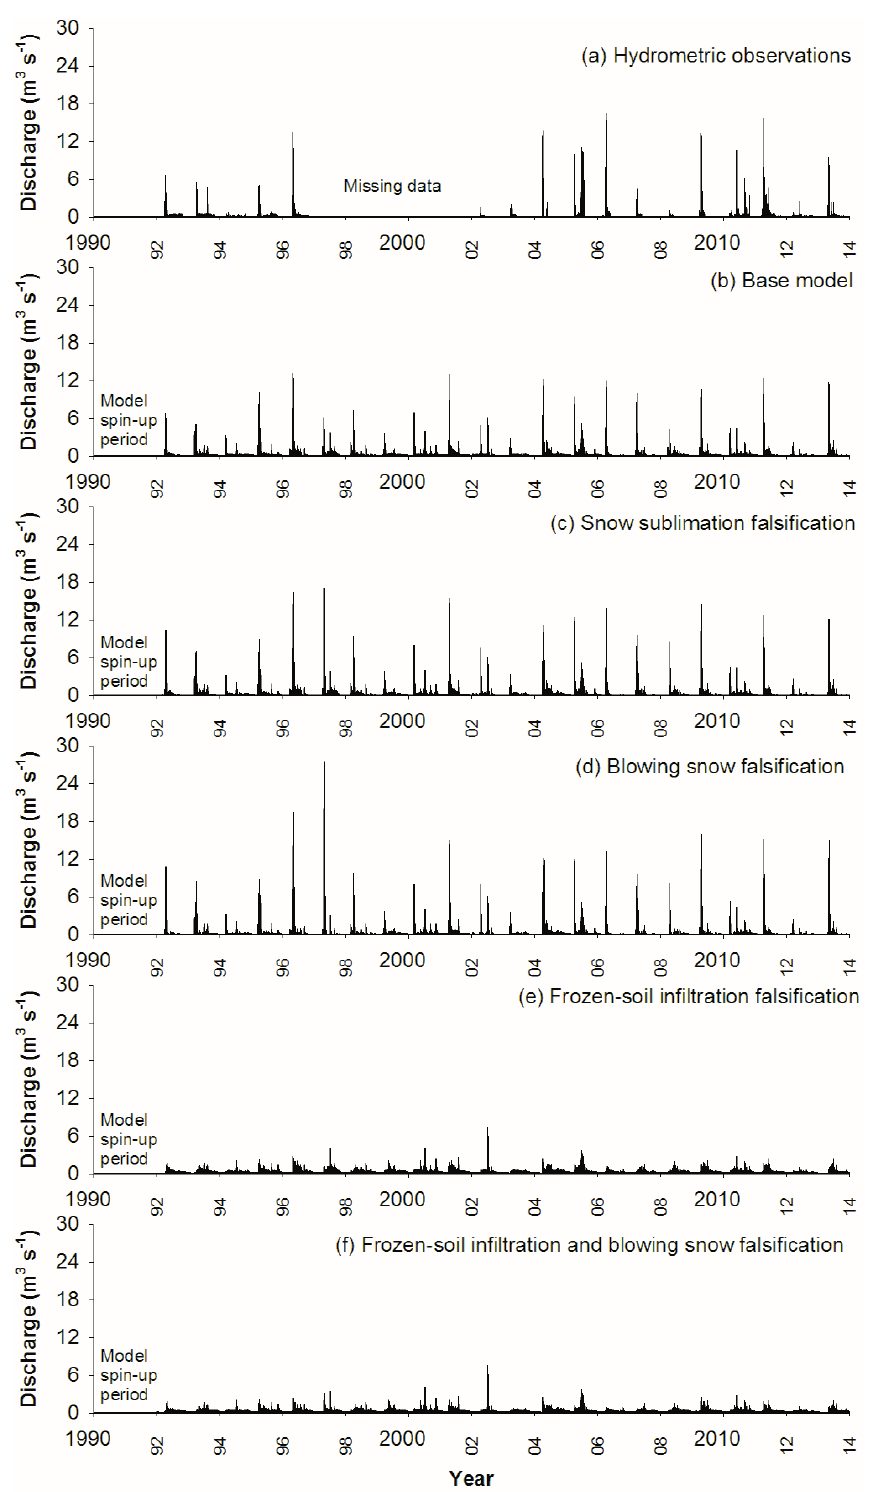
Figure 10. Observed hydrograph (a) and model simulations (1992–2013) for the base model (b) and the different model falsifications, which include inhibition of snow sublimation (c) , blowing snow (d) , frozen-soil infiltration (e) and frozen-soil infiltration combined with blowing snow (f) . Model spin-up period shown for reference